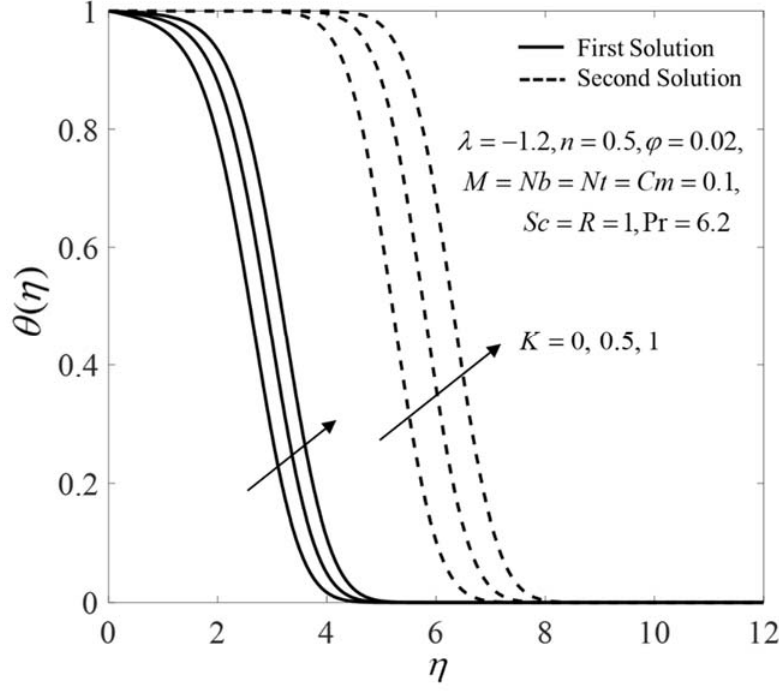
Figure 10. Temperature θ ( η ) for different K values.